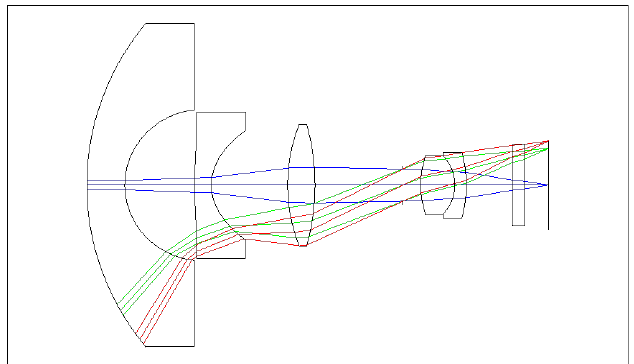
Figure 3. Five-lens structural design of a miniaturized wide-angle fisheye lens using an OKP4HT aspherical lens to replace a glass spherical lens.